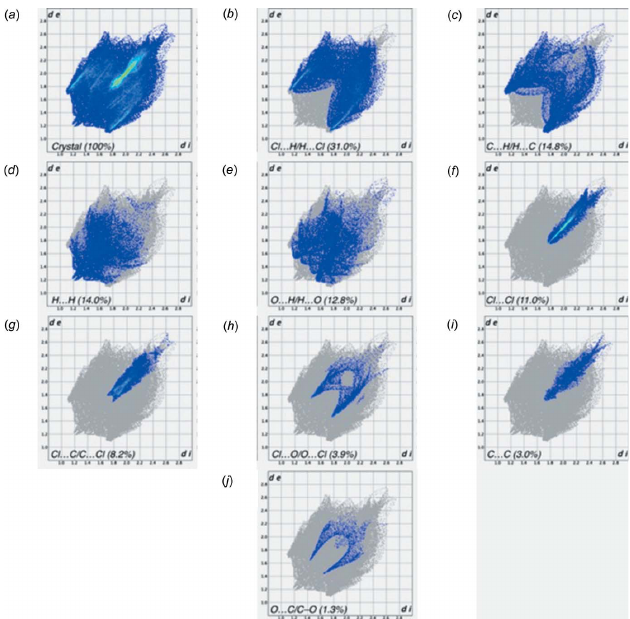
Figure 5 ( a ) The full two-dimensional fingerprint plot for the title compound, and those delineated into ( b ) Cl (cid:2)(cid:2)(cid:2) H/H (cid:2)(cid:2)(cid:2) Cl, ( c ) C (cid:2)(cid:2)(cid:2) H/H (cid:2)(cid:2)(cid:2) C, ( d ) H (cid:2)(cid:2)(cid:2) H, ( e ) O (cid:2)(cid:2)(cid:2) H/H (cid:2)(cid:2)(cid:2) O, ( f ) Cl (cid:2)(cid:2)(cid:2) Cl, ( g ) Cl (cid:2)(cid:2)(cid:2) C, ( h ) Cl (cid:2)(cid:2)(cid:2) O, (i) C (cid:2)(cid:2)(cid:2) C and ( j ) O (cid:2)(cid:2)(cid:2) C contacts.